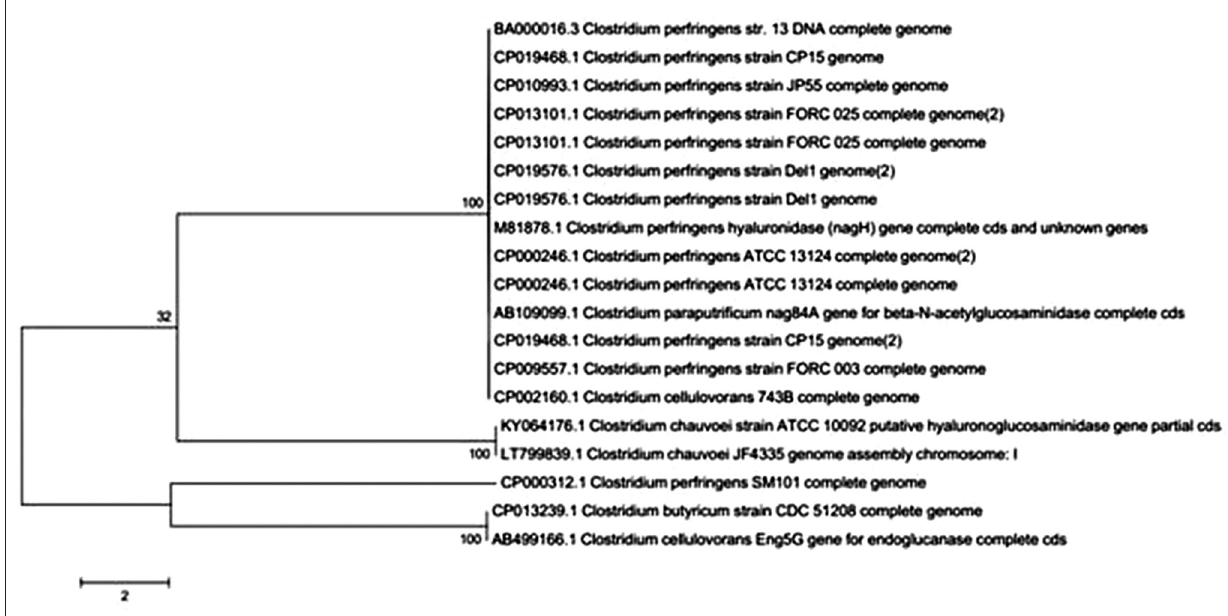
Figure-4: Phylogenetic analysis of nagH gene of Clostridium